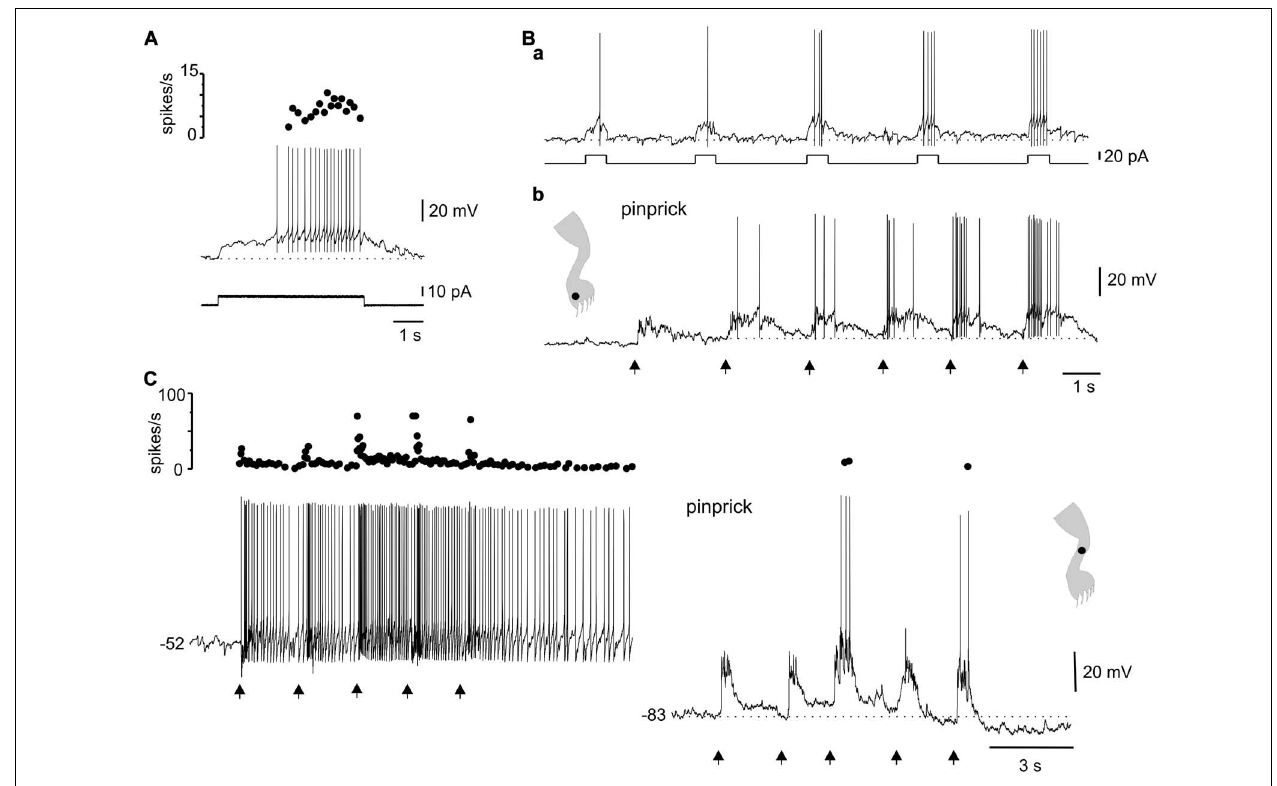
pinprick on a spot (dot in cartoon) of the excitatory receptive field (b) . (C) Windup of the response to repeated pinprick at rest ( − 52 mV, left trace). The windup of the response disappeared at hyperpolarized membrane potentials ( − 83 mV, right trace). (A,B) From the same